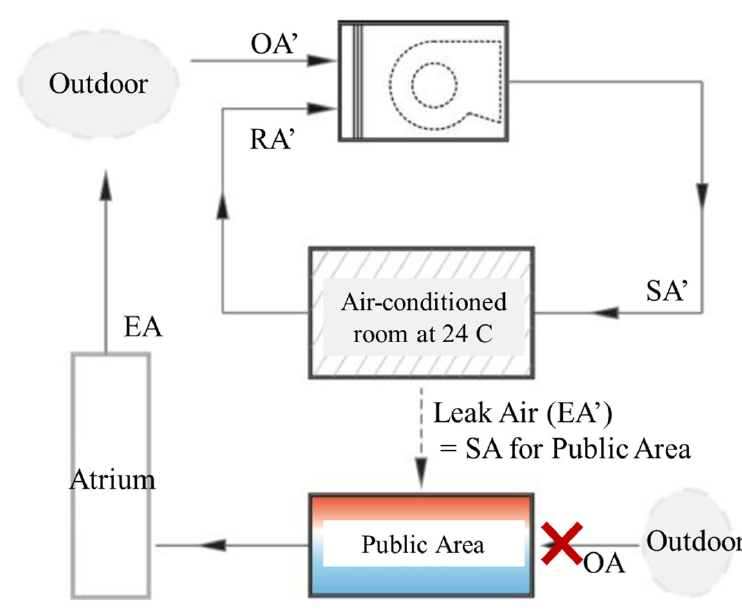
Figure 25. Cooling mechanism for entire building.